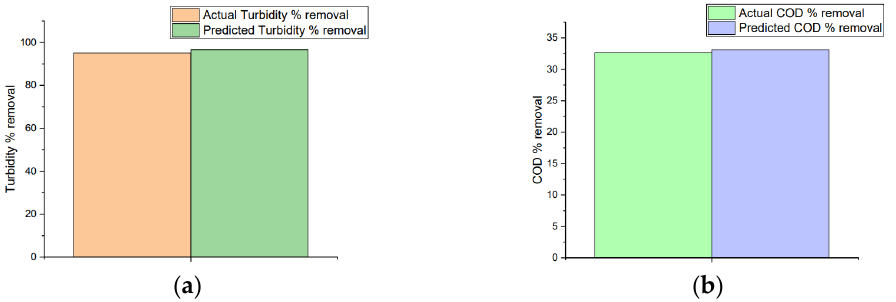
Figure 8. ( a ) Actual vs. predicted values of optimal turbidity removal; ( b ) Actual vs. predicted val- ues of optimal COD removal. Table 10. Modified RSM-CCD optimum conditions experimental